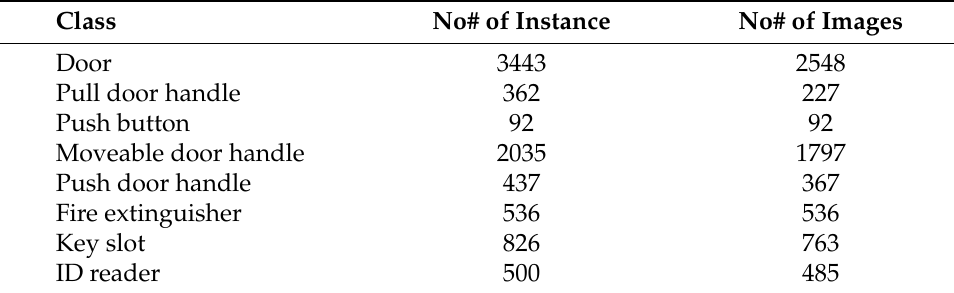
Table 1. Number of instances per class and the image